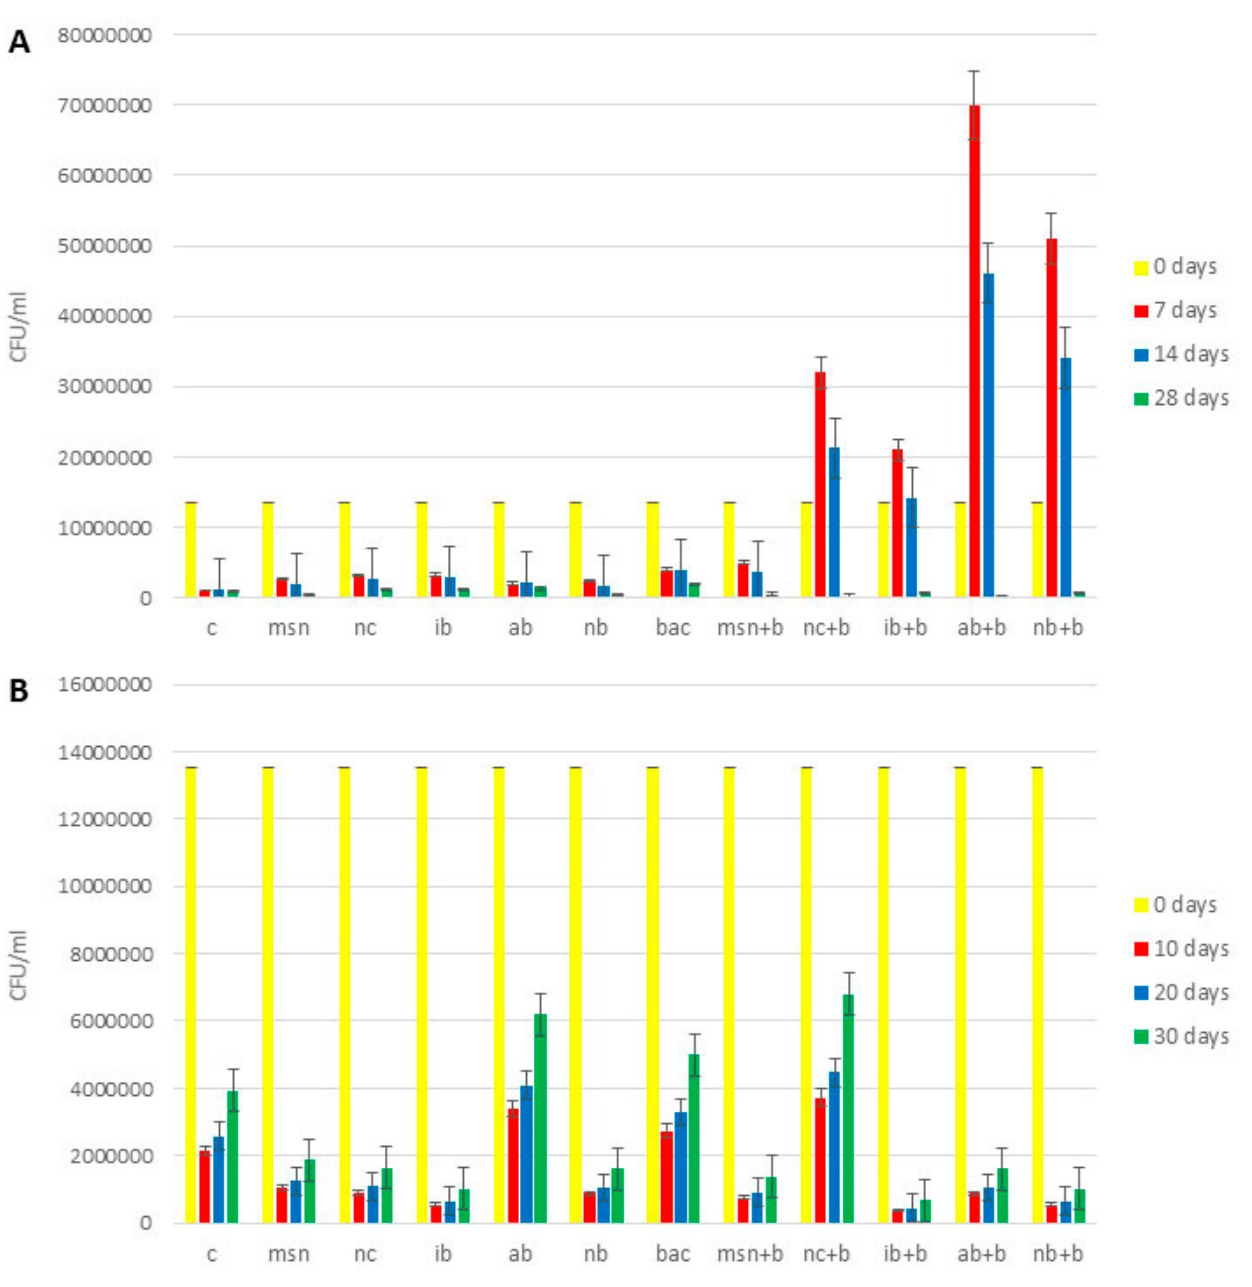
Figure 4. Content of total bacteria in soil. ( A ) 2nd tomato experiment; ( B ) watermelon